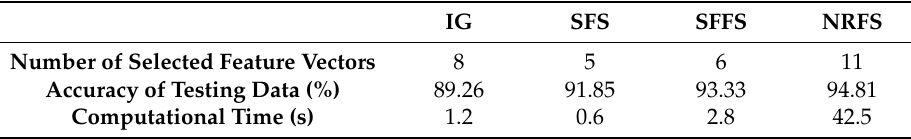
Table 5. Experimental results of original data set of EEG signals.